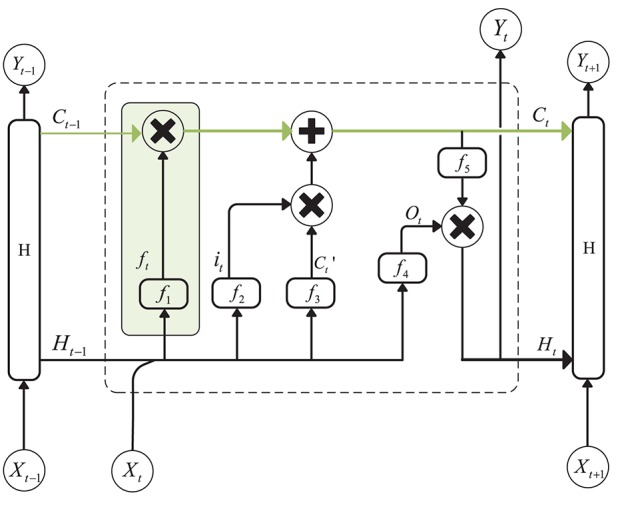
Structure of Long Short-Term Memory. The green line above the graph represents the cell state. The green box represents the gate, which controls the updating of the cell state.